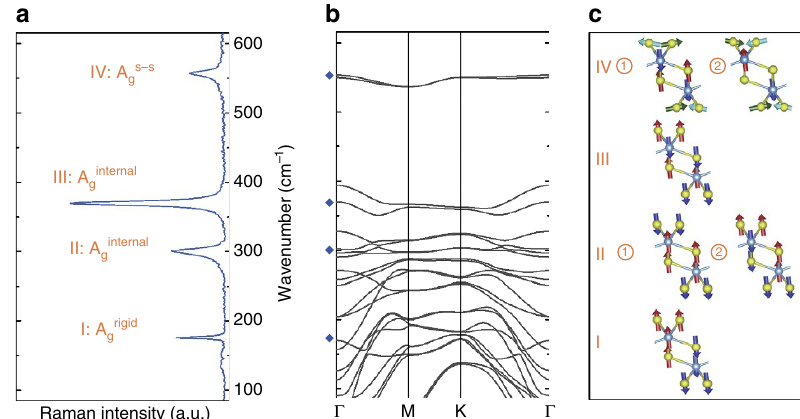
Figure 2 | Vibrational properties and phonon dispersion of TiS 3 . ( a ) Raman spectrum of TiS 3 whiskers measured in ambience at room temperature. ( b ) Phonon dispersion spectrum calculated using DFTof TiS 3 . The Raman active modes are highlighted by blue diamonds. ( c ) Corresponding Raman active optical modes in a .